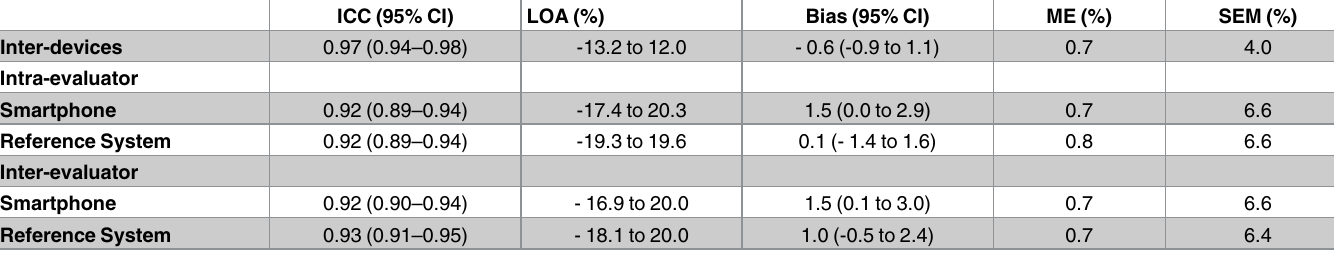
Table 3. Inter-devices and intra- and inter-evaluator reproducibility of the